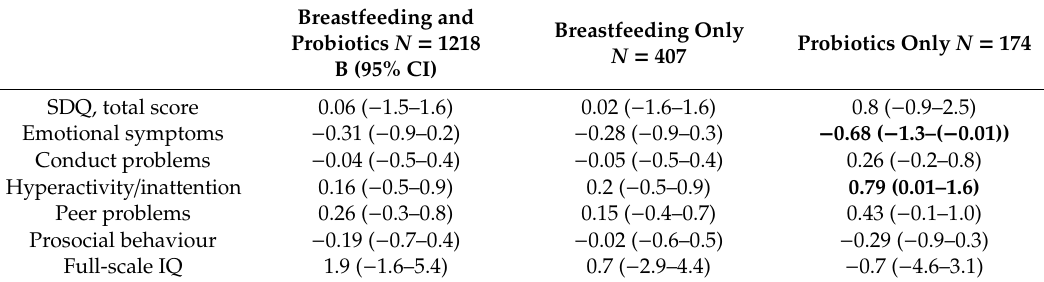
Table A2. Linear regression analysis for SDQ and IQ scores and subscores with combination of breastfeeding ≥ 3 months +/ − probiotics as one main